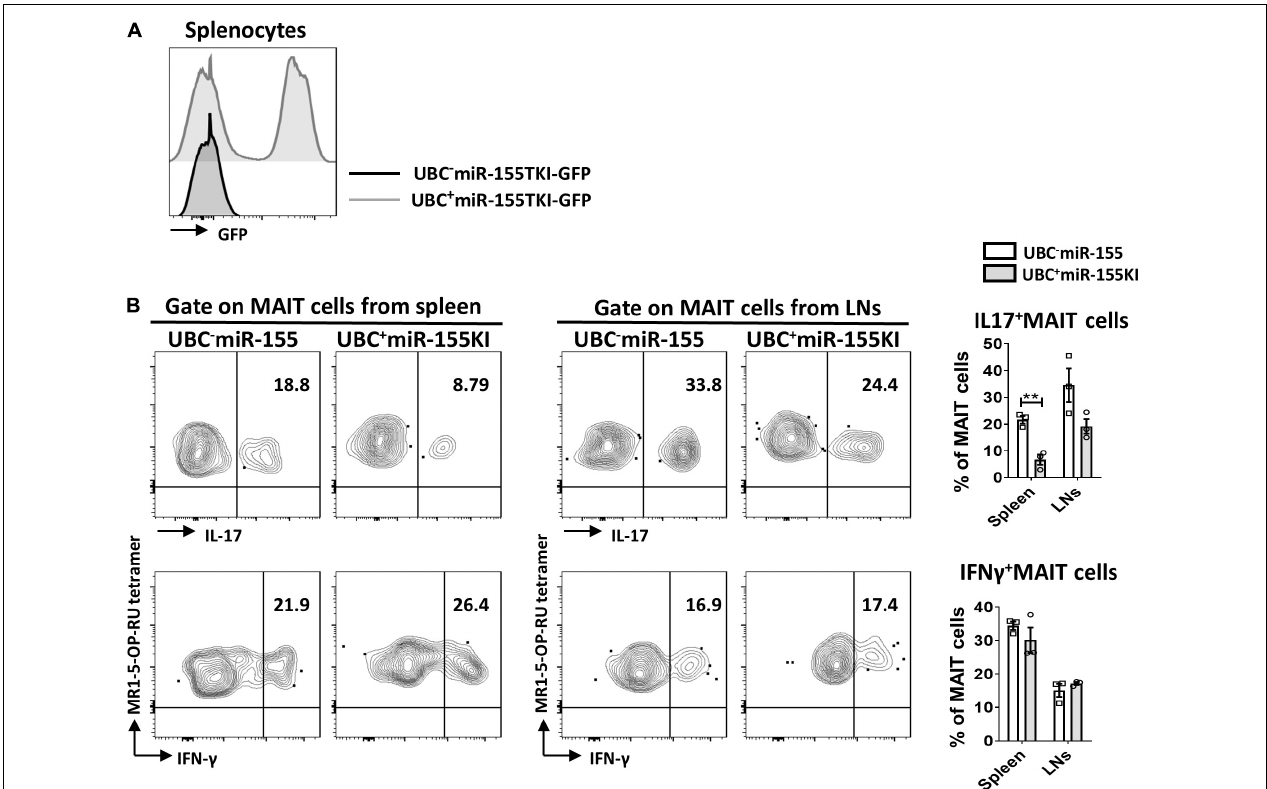
FIGURE 5 | miR-155 is essential to the function of MAIT cells. (A) Histogram showing GFP expression of splenocytes in UBC − miR-155 KI mice and UBC + miR-155 KI mice after tamoxifen treatment. (B) Cytokines (IL-17 and IFN- γ ) production of MAIT cells from spleen and LNs in UBC miR-155 KI mice. Data are from two independent experiments. Each mouse is represented as one dot. 3 mice for each group. Data were analyzed by unpaired t -test. ** p < 0.01 compared to